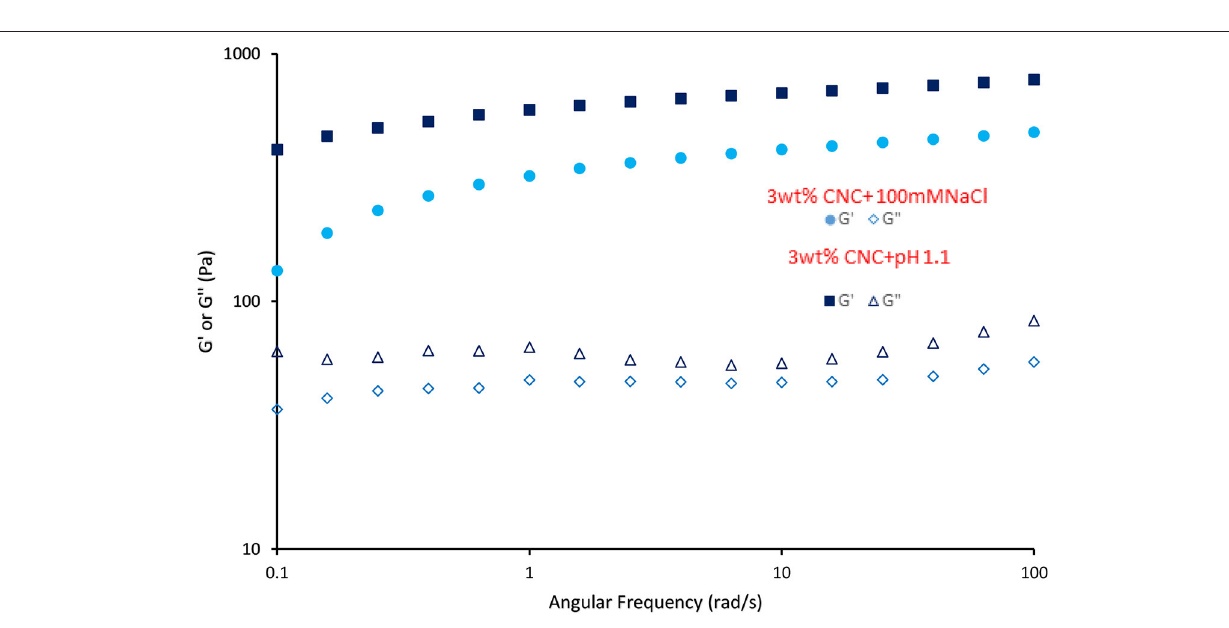
1 mM concentration are 9.6 nm and 1 mol/m 3 , respectively; at 3 mM concentration, these are 5.54 nm and 3 mol/m 3